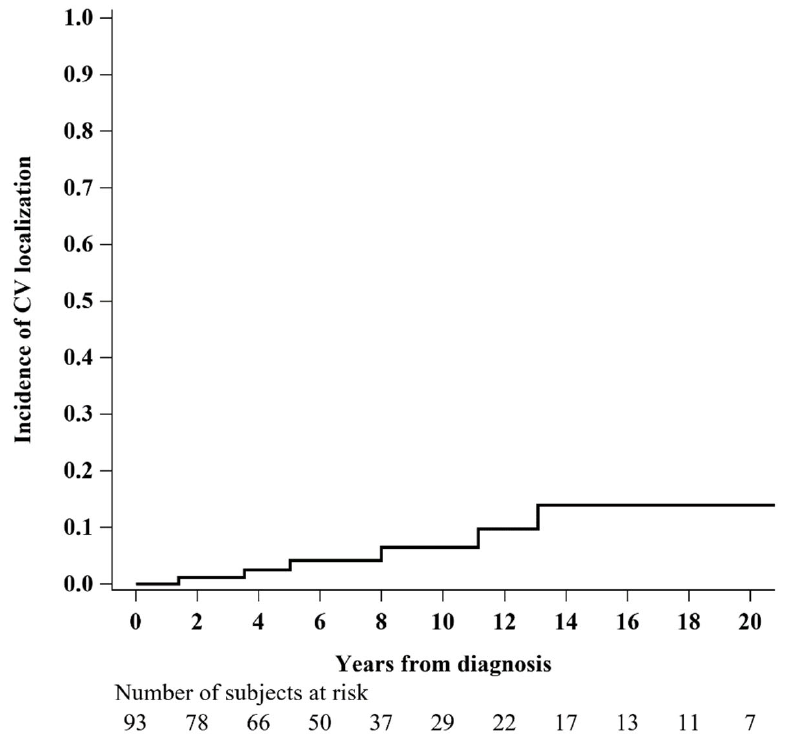
Figure 2. Cumulative incidence function of cervico-vaginal (CV) localization of vulvar EMPD, considering death as a competing event (N = 93).